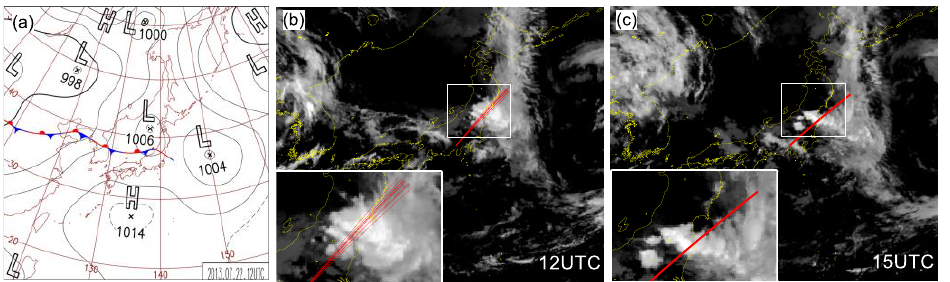
Figure 3. ( a ) JMA surface weather chart, ( b ) satellite image (JMA MTsat2) at 12 UTC, and ( c ) at 15 UTC associated with sprites. The red lines show the azimuths of sprite elements from the summit of Mt. Fuji. White rectangles show the sprite-producing MCSs.